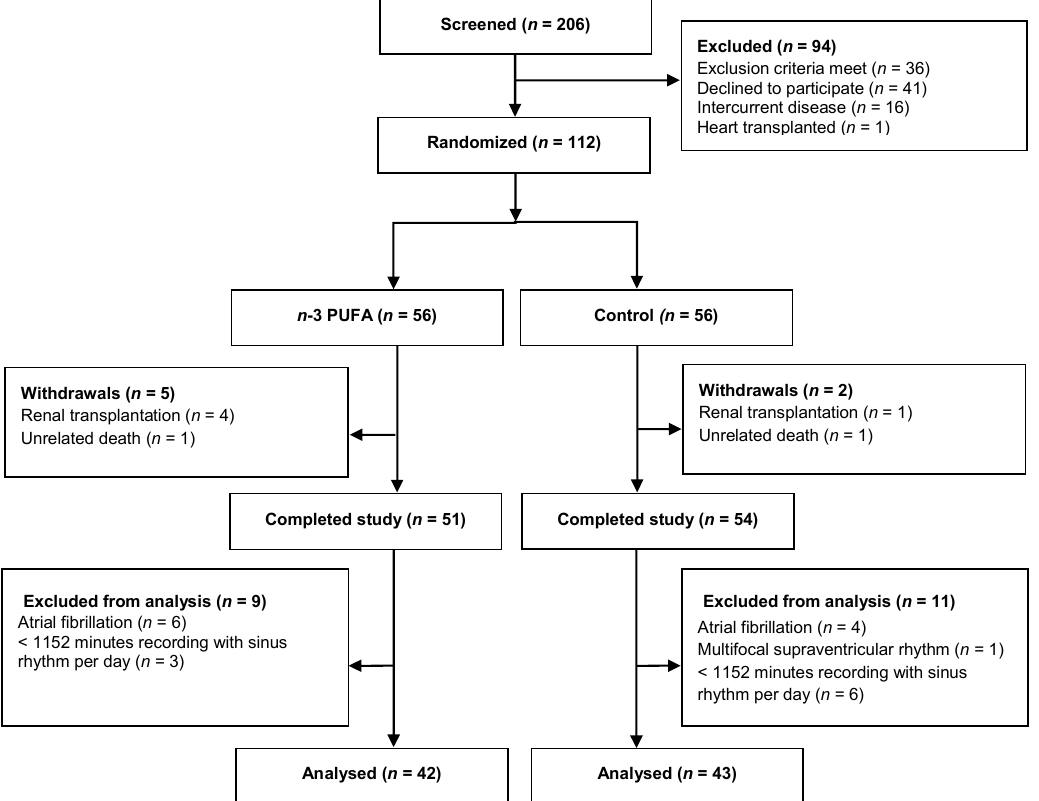
Figure 1. Patient enrolment, randomization and completion flow diagram. PUFA, polyunsaturated fatty acids; and, HRV, heart rate variability.